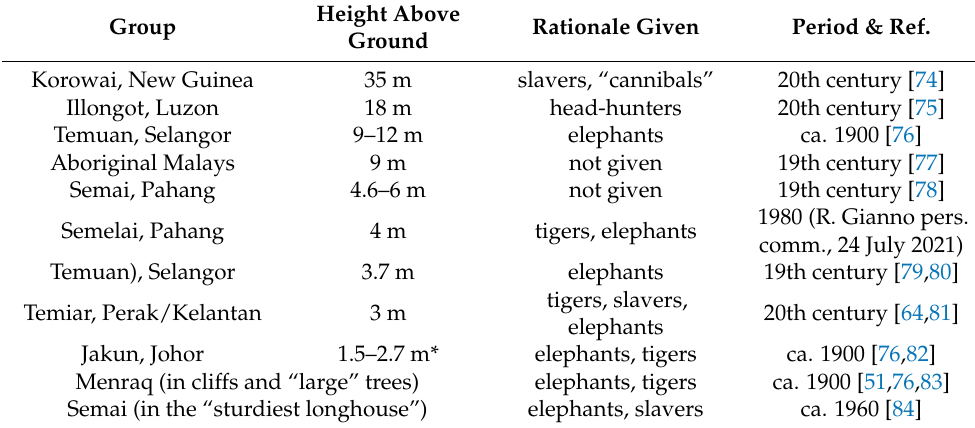
Table 3. Above-the-ground shelters of the Orang Asli and other groups. Height Above Group Rationale Given Period & Ground